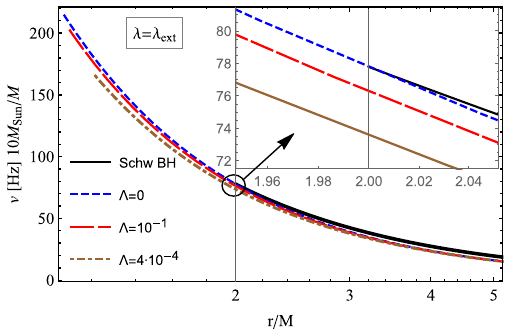
Fig. 9 Radial dependence of Keplerian frequencies of test particles around a Schwarzschild–de Sitter BHs for the different values of the cosmologicalconstant.Inthisplot,weuse Λ → Λ/ M 2 and Λ → Λ/